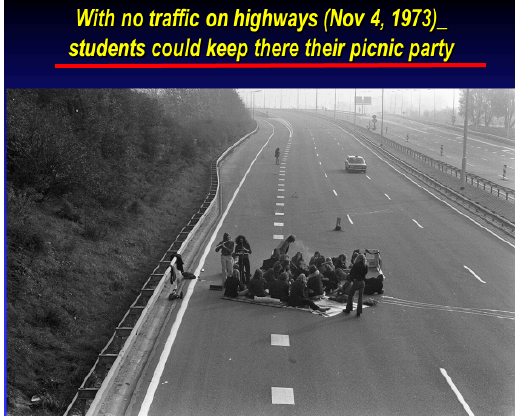
Figure 1. For a few days during so-called energy crisis, all private cars were banned in some EU countries (Holland is shown in this picture, source unknown).